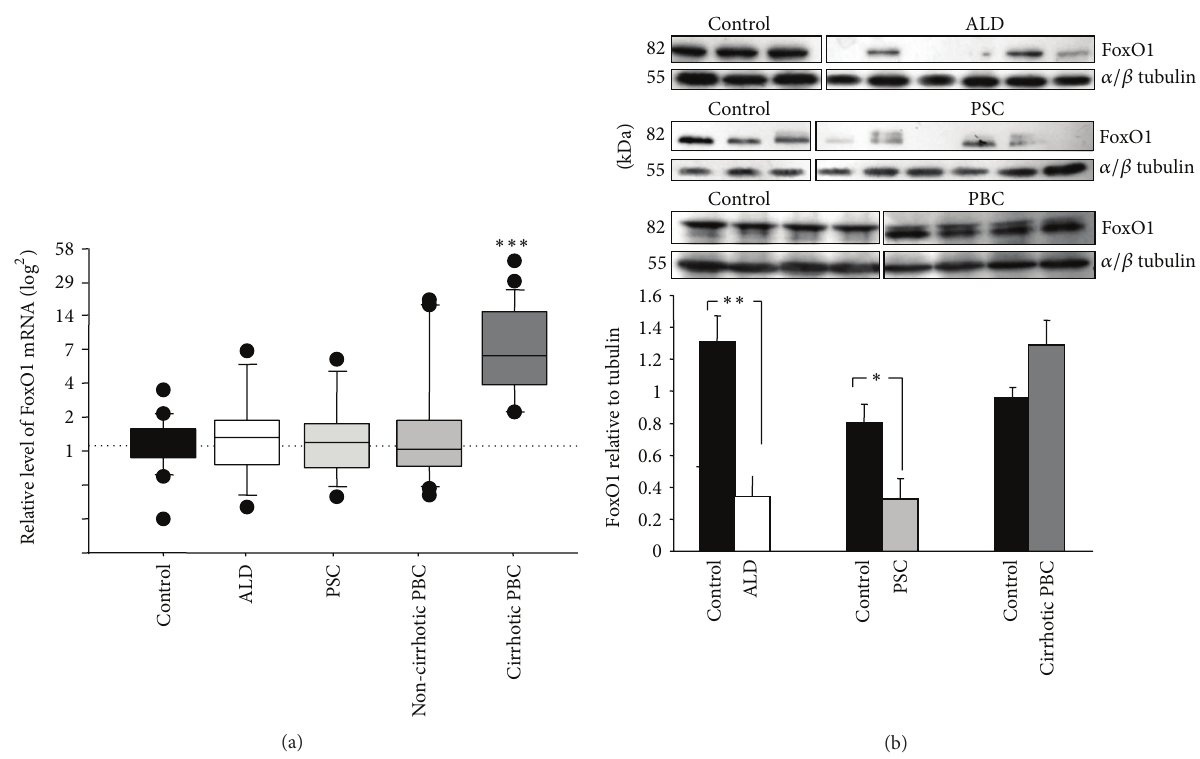
Figure1:FoxO1expressioninnon-cirrhoticPBC,cirrhoticPBC,ALD,PSC,andcontrols.(a)mRNAand(b)protein.Levelsofgeneexpression presented as fold-change relative to control were normalized with glyceraldehydes 3-phosphate dehydrogenase (GAPDH). Changes in FoxO1 protein levels were determined by densitometry analyses after normalization to 𝛼 / 𝛽 tubulin as a control for loading. Bars indicate the mean ± SEM ( ∗ 𝑃 < 0.05 ; ∗∗ 𝑃 < 0.005 ; ∗∗∗ 𝑃 < 0.0001 versus